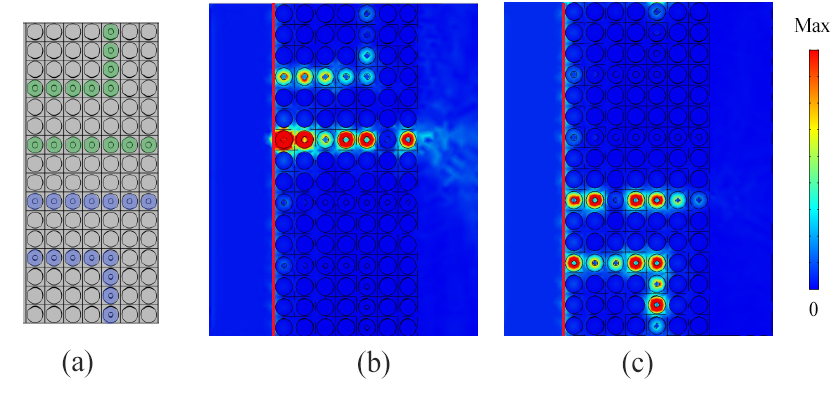
Figure 6. ( a ) The demultiplexer system consists of two waveguides channels, W 1 = 0.155 a (green) and W 2 = 0.130 a (blue) each with its own respective linear and L-shaped configuration ( b ) the computed transmission coefficient for W 1 = 0.155 a at 810 kHz and ( c ) W 2 = 0.130 a at 880 kHz. The red line on ( b , c ) indicate the excitation source of the